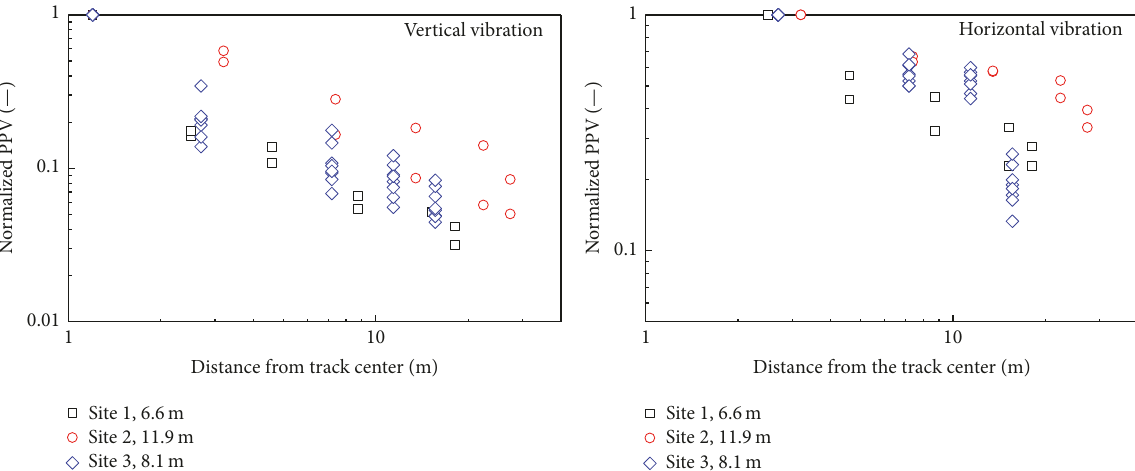
Figure 14: Normalized PPV attenuation rule with distance from track center in vertical and horizontal